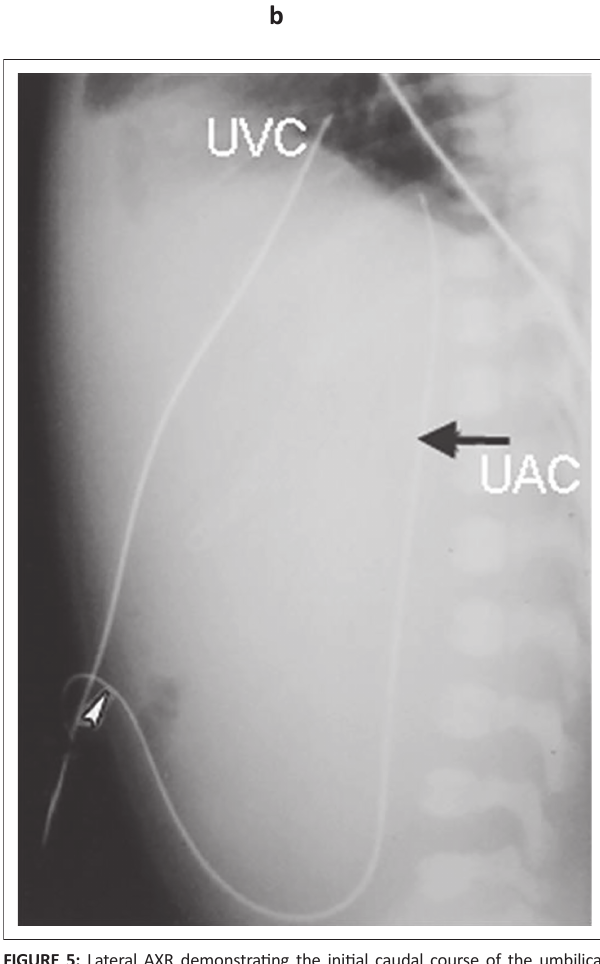
FIGURE 5: Lateral AXR demonstrating the initial caudal course of the umbilical arterial catheter (UAC). The UAC also has a more posterior course within the iliac arteries and the aorta. The umbilical venous catheter (UVC) passes more anteriorly. FIGURE 6: The umbilical arterial catheter (UAC) is positioned to the right of